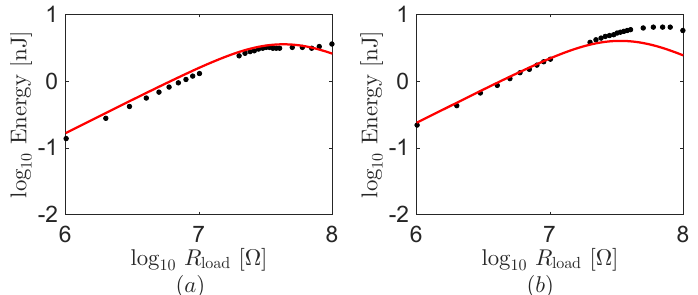
Figure 10. Theoretical predictions and experimental results on energy transferred to the load resistance as a function of the resistance using the robot finger. ( a ) One click and ( b ) double click. Black dots and red lines are the experimental results and the theoretical predictions, respectively.